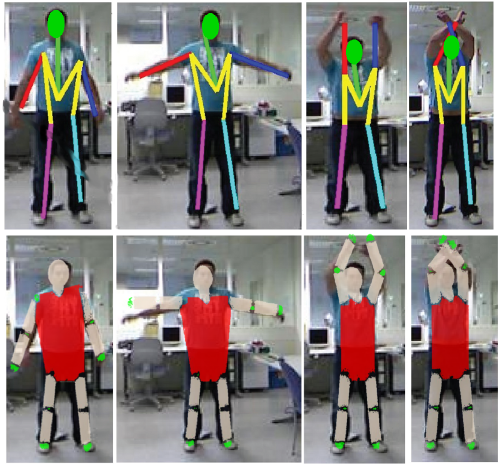
Figure 6. Results of our method after inverse kinematics (IK). The second row shows the model and joints being inferred (elbows and